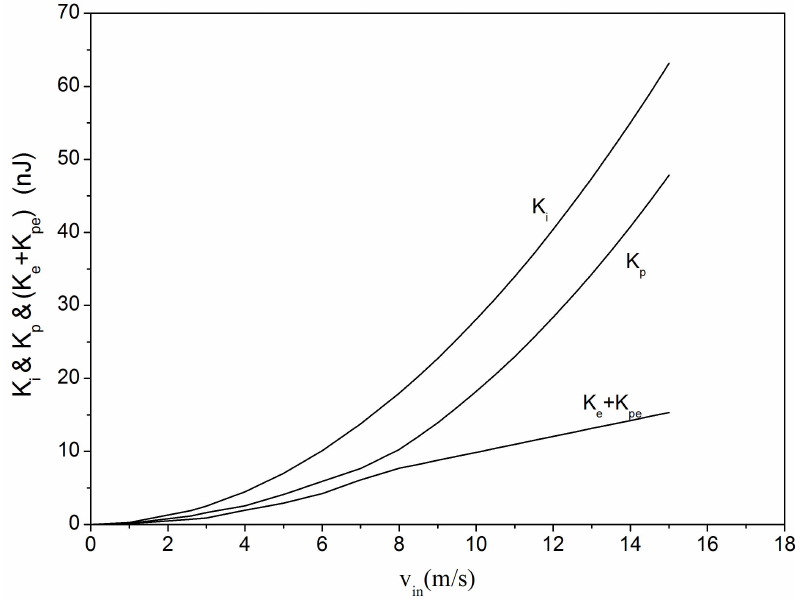
Figure 11. The incident kinetic energy K energy K + K for fly ash particles of 75 μ m diameter hitting a planar steel plate at different e pe impact